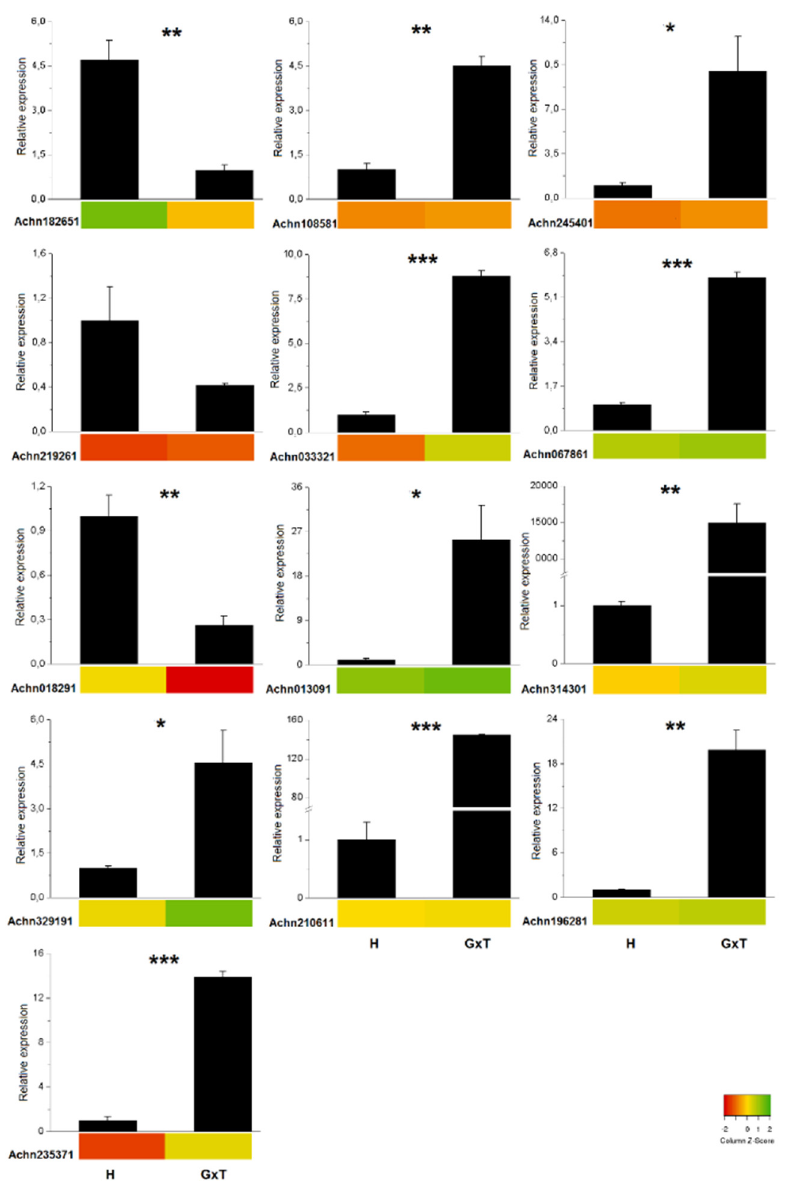
Figure 5. The expression levels of genes revealed by RT-qPCR and RNA-seq. The heatmap shows the FPKM values for the 15 selected candidate genes. The color scale indicates changes in the fold of gene expression. The bar graphs show the results of RT-qPCR in terms of relative expression. On each panel, left bars represent H-female samples, and right bars represent G × T-male samples. The annotation of the selected genes was: Achn182651: AGAMOUS MADS-box transcription factor; Achn108581: Transcription factor, contains DNA-binding, integrase-type domain; Achn245401: CONSTANS pro-